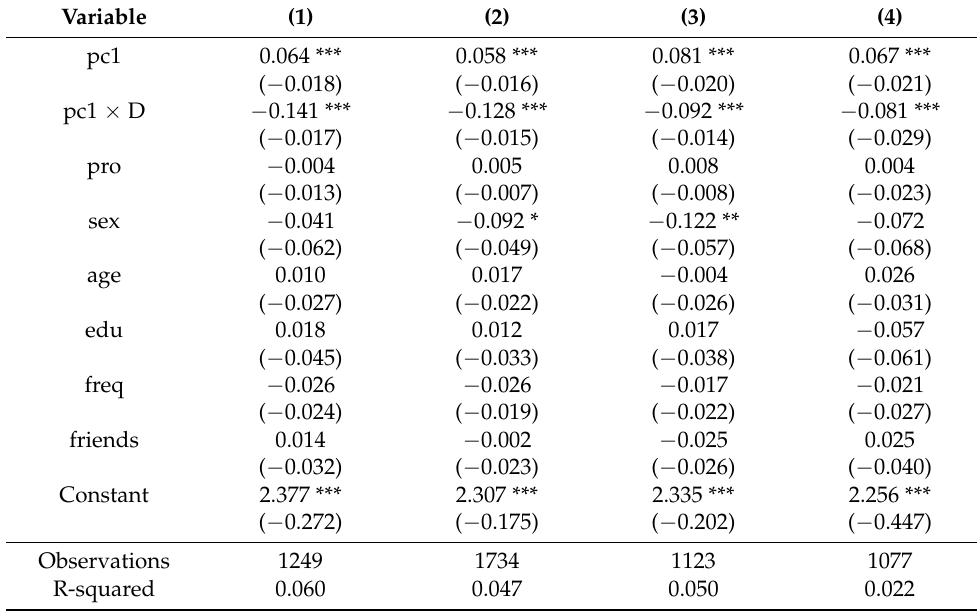
Table 8. The result of robustness